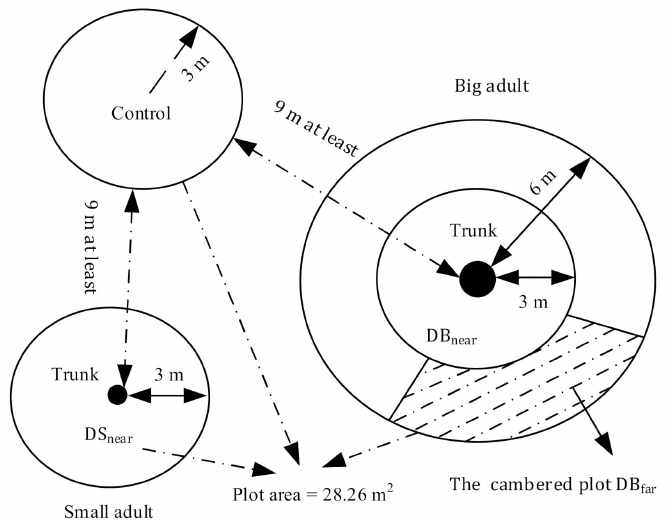
Figure 2. A schematic diagram of the sampling site